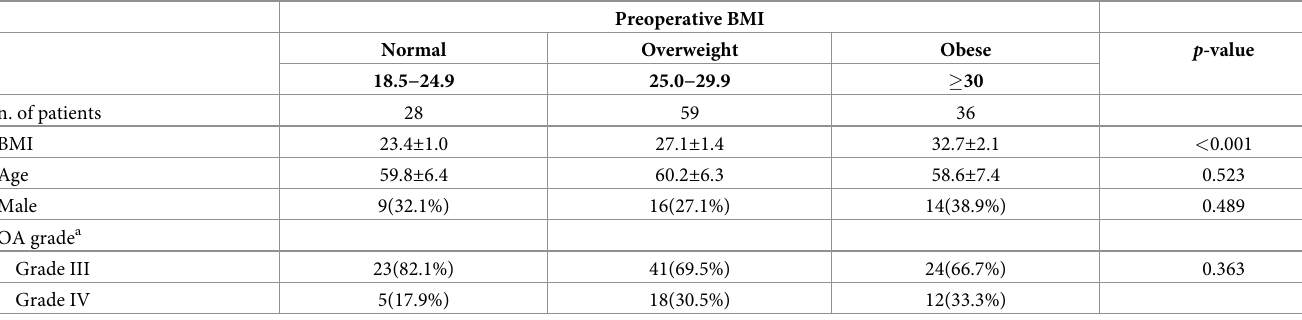
Table 1. Patient